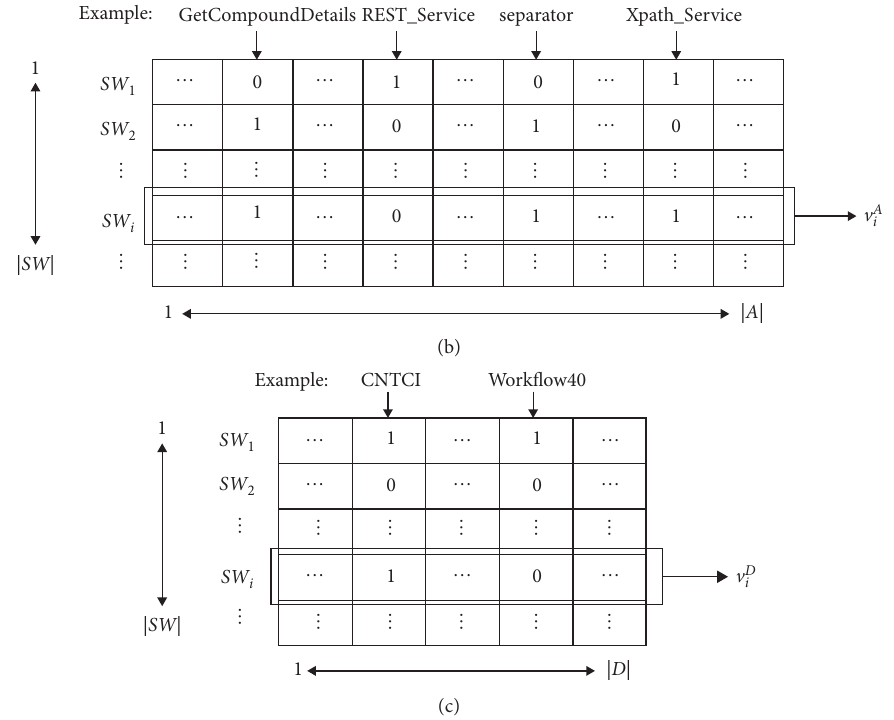
Figure 4: An example of three adjacent matrices and feature vectors. (a) SWT . (b) SWA . (c) SWD